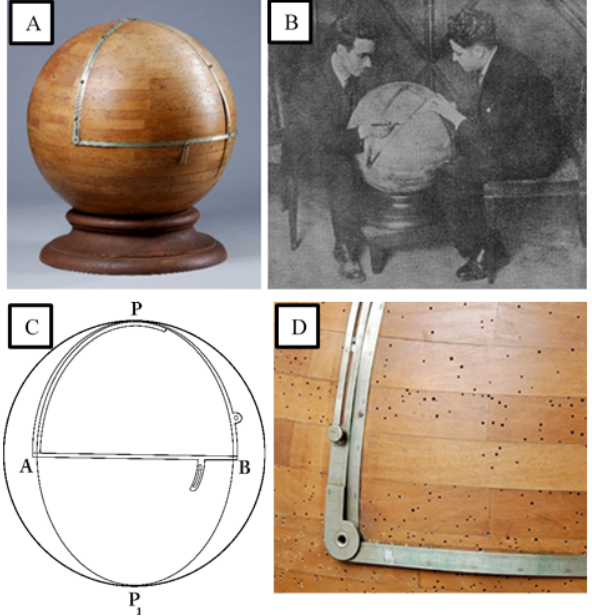
Figure 10. The Costa Lobo’s Solar Sphere (A) (Photo by Gilberto Pereira) and the working process with the sphere (B) [Source: Lobo (1934). The outline draw of the metallic armature (C) [Source: Lobo (1934)] and a detail of the graduated armature (D).